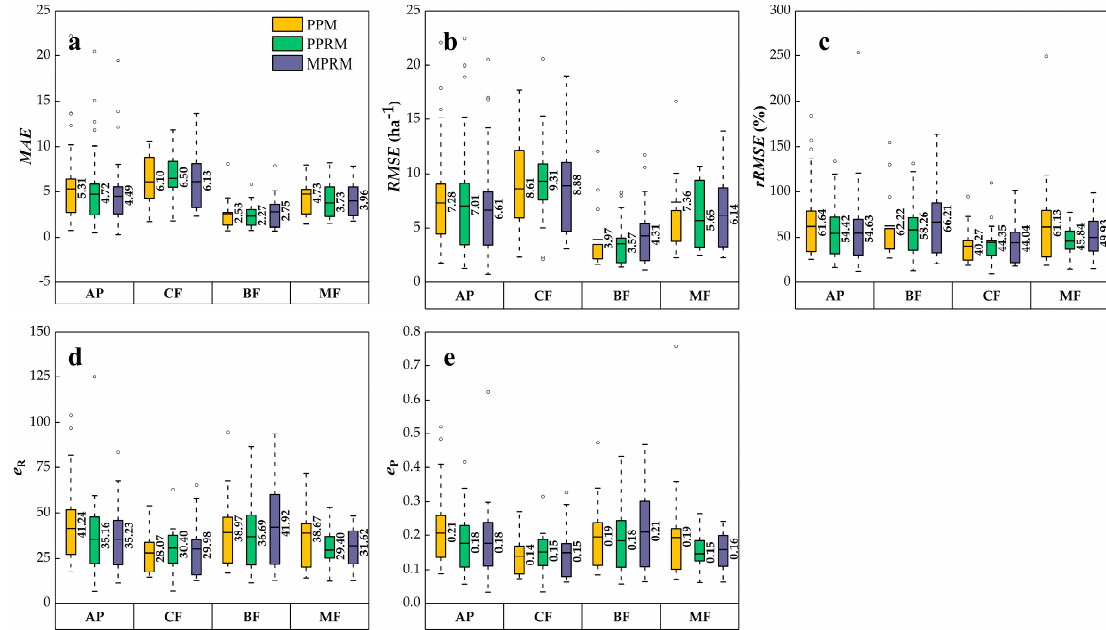
Figure 5. The box plots for the comparison of reference and predicted individual tree volume distributions in different Weibull parameter predictive models (PPM, PPRM, and MPRM) using field reference stem density N ref as the scaling variable. The goodness-of-fit for predicted volume distributions was evaluated by MAE ( a ), RMSE ( b ), rRMSE ( c ), e R ( d ), e P ( e ). The number beside each box represents the mean value of the relative statistics. PPM: parameter prediction method; PPRM: percentile-based parameter recovery method; MPRM: moment-based parameter recovery method; AP: all plots; CF: coniferous forest plots; BF: broadleaved forest plots; MF: mixed forest plots. In comparison, when the LiDAR-predicted stem density was used as the scaling variables to estimate the total distribution frequency in each volume class, modelling volume distributions based on the PPRM (average mean e R = 37.75, average mean e P = 0.17) performed better than the modelling based on the MPRM (average mean e R = 40.43, average e P = 0.18) and PPM (average mean e R = 41.22, average e P = 0.18) in terms of error indexes, which were similar to the results when using field stem density as the scaling variable (Figure 6). The mean values of MAE , RMSE, and rRMSE of the modelling distributions based on the PPRM obtained values of 2.60–6.81, 2.84–11.29 and 51.53–70.61 trees/ha, respectively. The volume distributions predicted from the LiDAR data produced relatively higher error indexes (mean e R = 31.47–54.07, mean e P = 0.15–0.21) than those produced using scaling with field-measured stem density (mean e R = 28.07–41.92, mean e P =